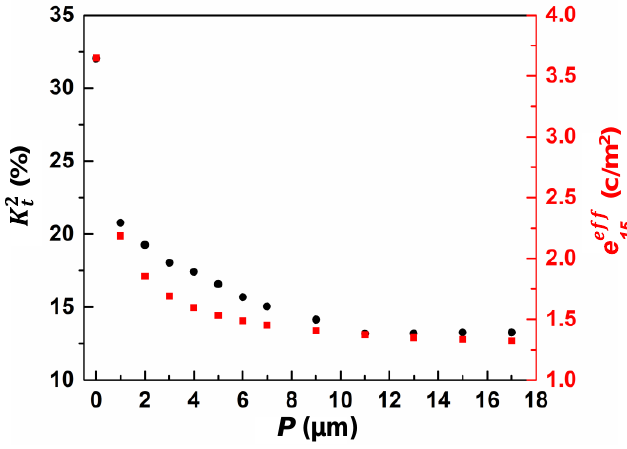
Figure 5. The variation in 𝐾 𝑡2 and 𝑒 15𝑒𝑓𝑓 with different widths ( P ) of nonpiezoelectric materials.